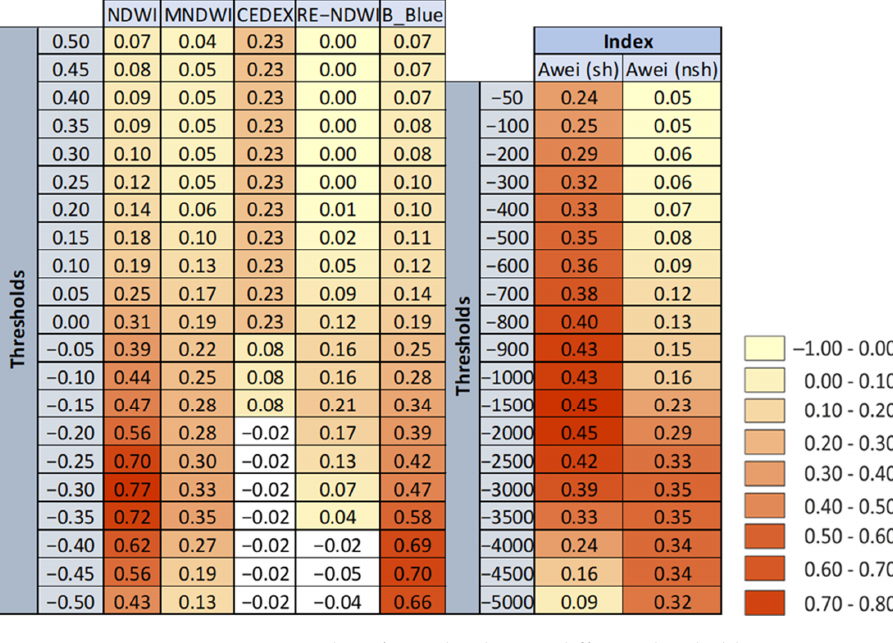
Water 2020 , 12 , x FOR PEER REVIEW Figure 4. Kappa index of tested indices at different thresholds. Figure 4. Kappa index of tested indices at di ff erent thresholds.